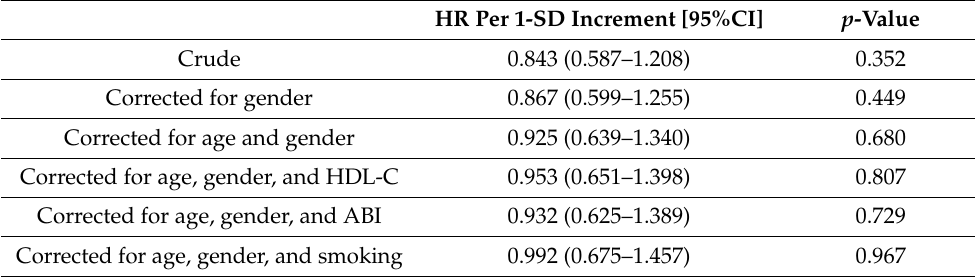
Figure 2. Kaplan–Meier curves for mortality by gender-stratified tertiles of CEC. Statistical difference was determined using the log-rank test. Table 3. Hazard ratios for mortality by CEC.